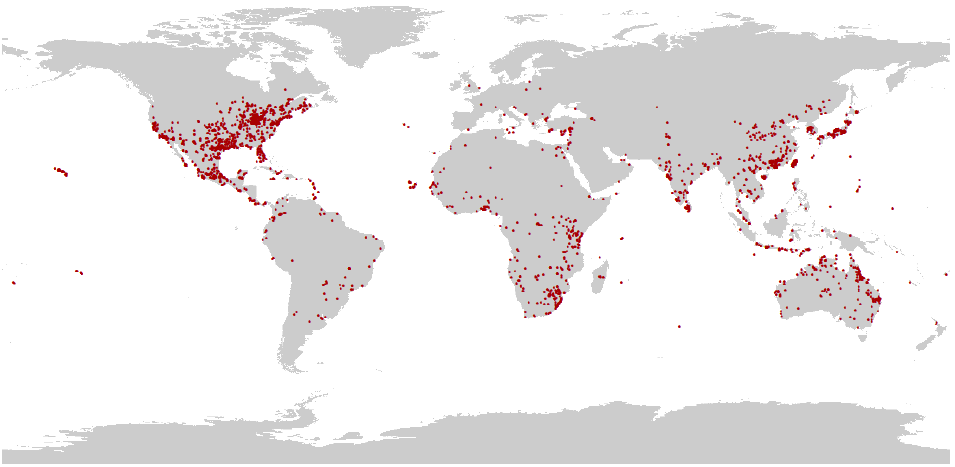
Figure 2. Occurrence recorded of P. flavescens in the